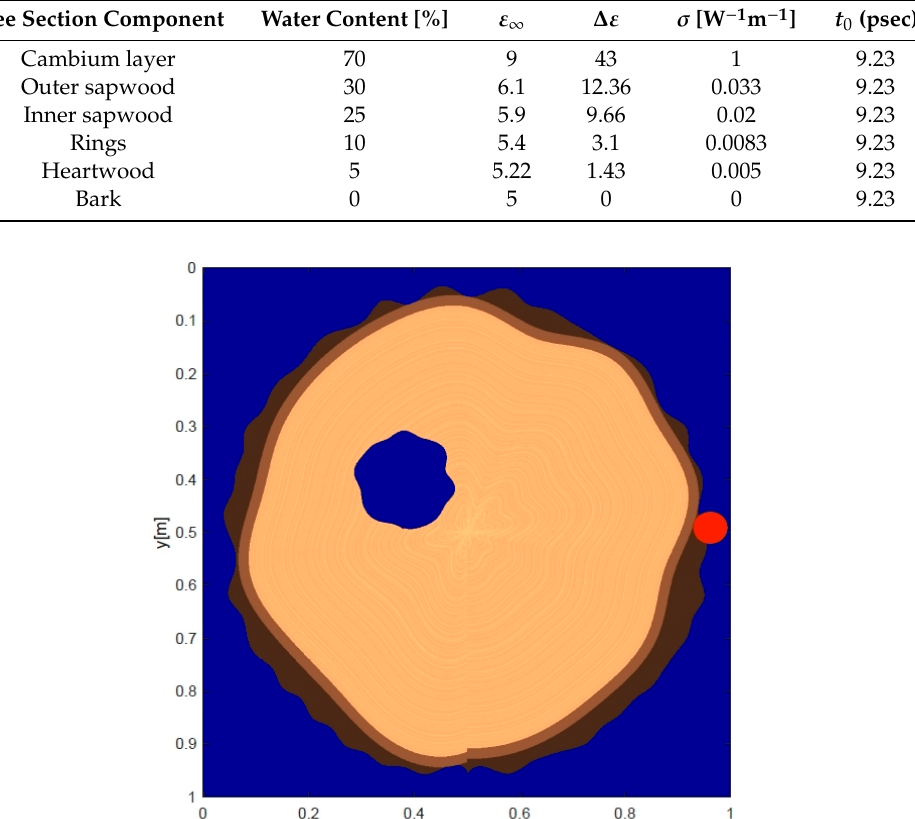
Figure 2. The circular softwood trunk scenario investigated using Finite-Difference Time-Domain (FDTD) numerical modelling. The starting point of the measurements, taken clockwise, is represented by the red circle.